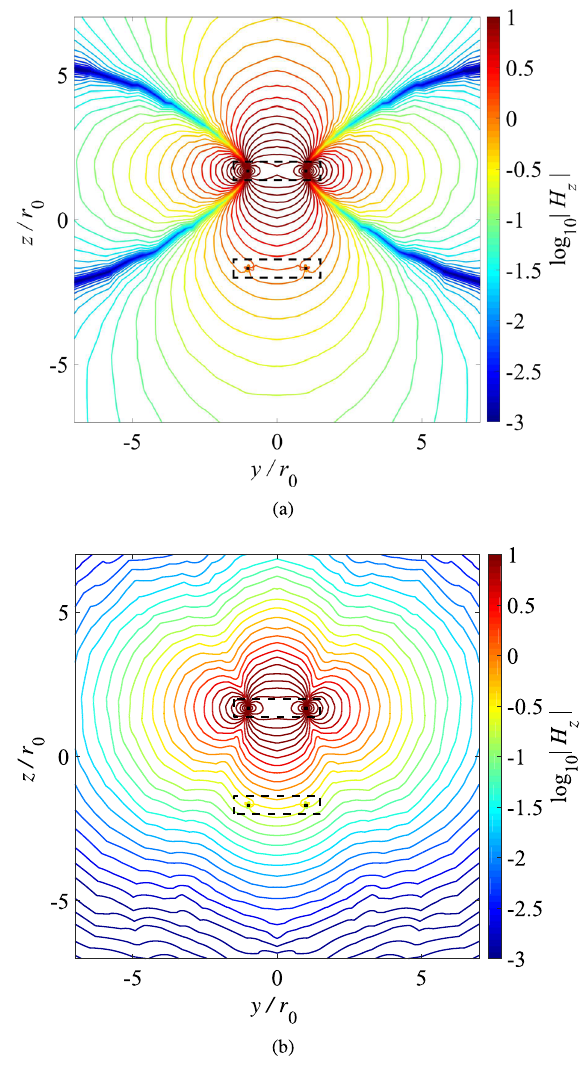
Fig. 8. Contour map of the modulus of H z component of the magnetic fi eld generated by a transmitting coil with a radius of r 0 =11mm and spaced apart d =37mm inside a conductive mediumwithconductivity(a) s =0and(b) s =10S/m.Blackdash lines mark the cross sections of the insulating dielectric